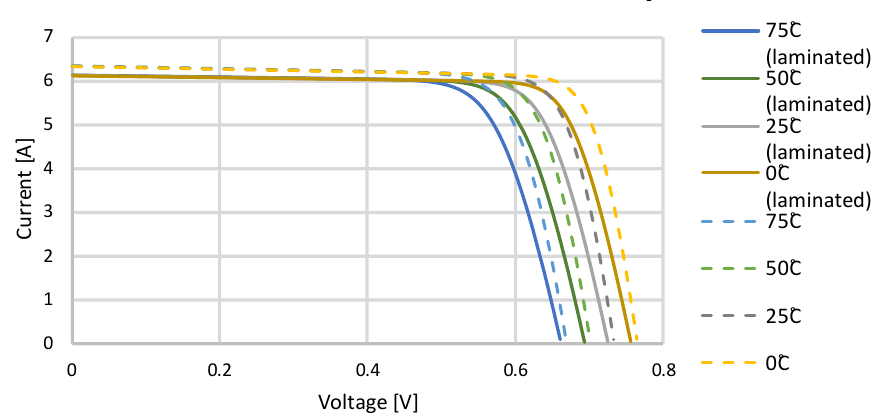
Figure 12. I – V curve at different temperatures for a SunPower Maxeon Ne3 cell. Figure 12. I–V curve at different temperatures for a SunPower Maxeon Ne3